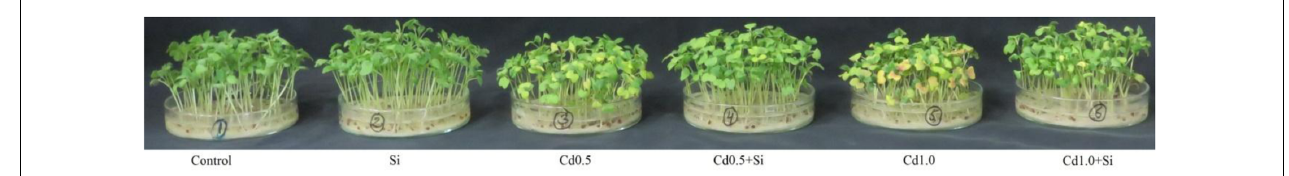
FIGURE 7 | Phenotypic appearance of Brassica napus seedlings grown under Cd stress induced by exogenous Si. Si, Cd0.5 and Cd1.0 indicate 1.0 mM SiO 2 , 0.5 mM CdCl 2 and 1.0 M CdCl 2 ,